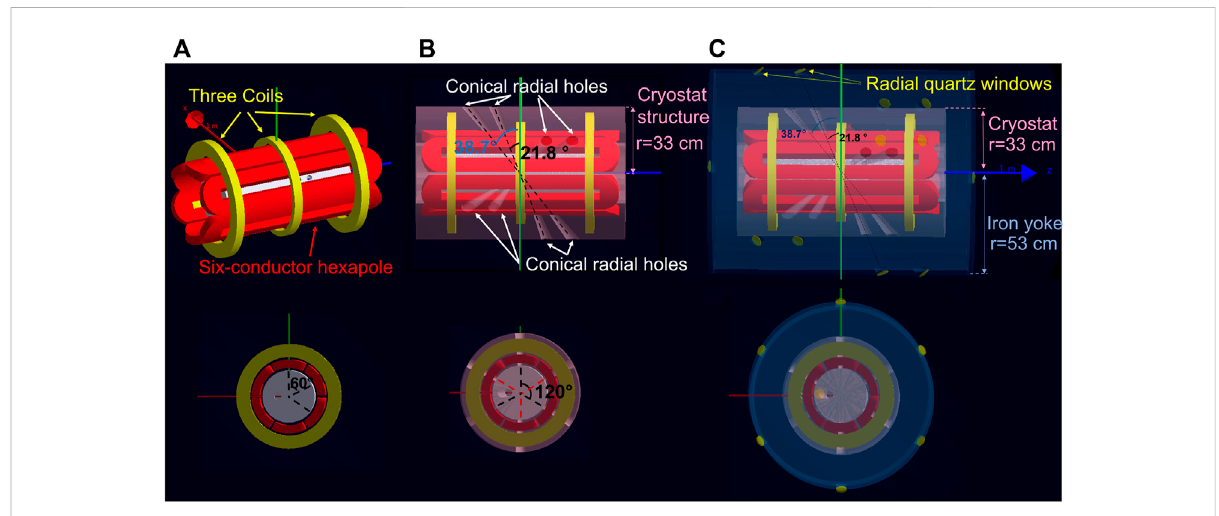
FIGURE 4 (A) Plasma chamber surrounded by superconducting coils (yellow) and hexapole (red); (B) magnetic system surrounded by the cryostat structure (pink) in which tapered holes used as lines of sight for gamma-ray detection are shown; (C) ARMCO ® iron yoke (blue) surrounding the magnetic plasma trap.